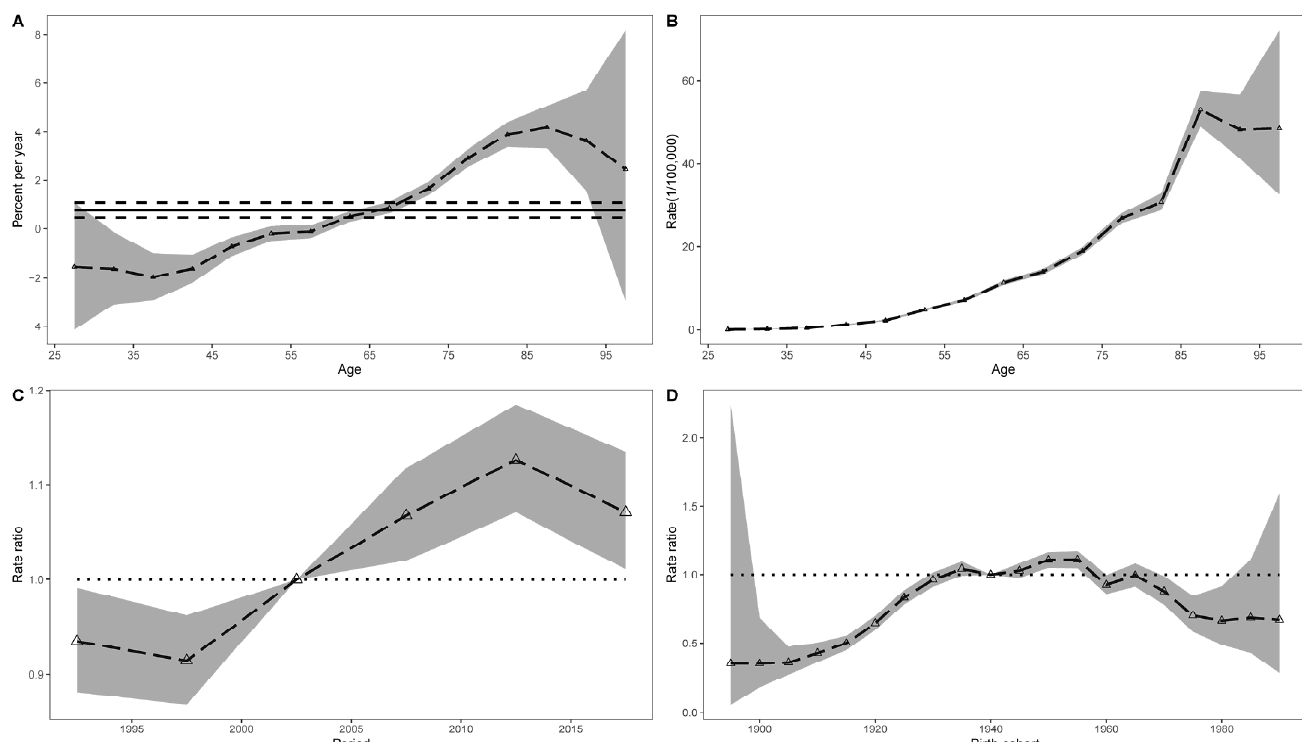
Figure 2. Effects of age, time period, and cohort on lung cancer deaths attributed to occupational carcinogens from 1990 to 2019 in China. ( A ) Local drifts with net drift values; the horizontal solid and dashed lines represent the net drift and its 95% CI respectively, the dashed line and shaded area represent the local drifts and their 95% CIs. ( B ), Fitted longitudinal age curves of mortality of lung cancer, the dashed line and shaded area represent age ‐ specific lung cancer mortality due to occupational carcinogens and their 95% CIs, respectively. ( C ) Relative risks of each period compared with the reference period (2000–2004) (dashed line with triangle), adjusted for age and cohort effects, and the corresponding 95% CIs (shaded area). ( D ) Relative risks of each cohort compared with the reference cohort (cohort 1940–1944) (dashed line with triangle), adjusted for age and time period effects, and the corresponding 95% CIs (shaded area).